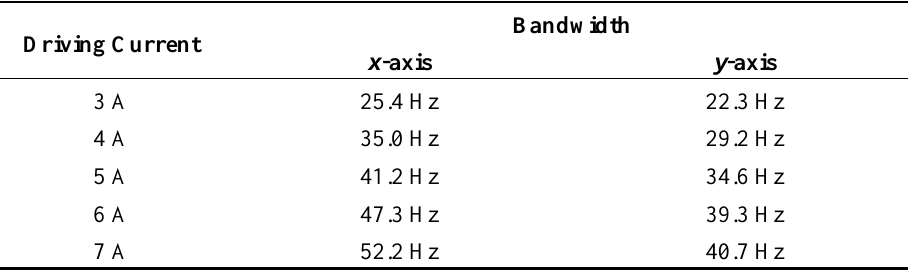
Table 3. Bandwidth of the actuator.